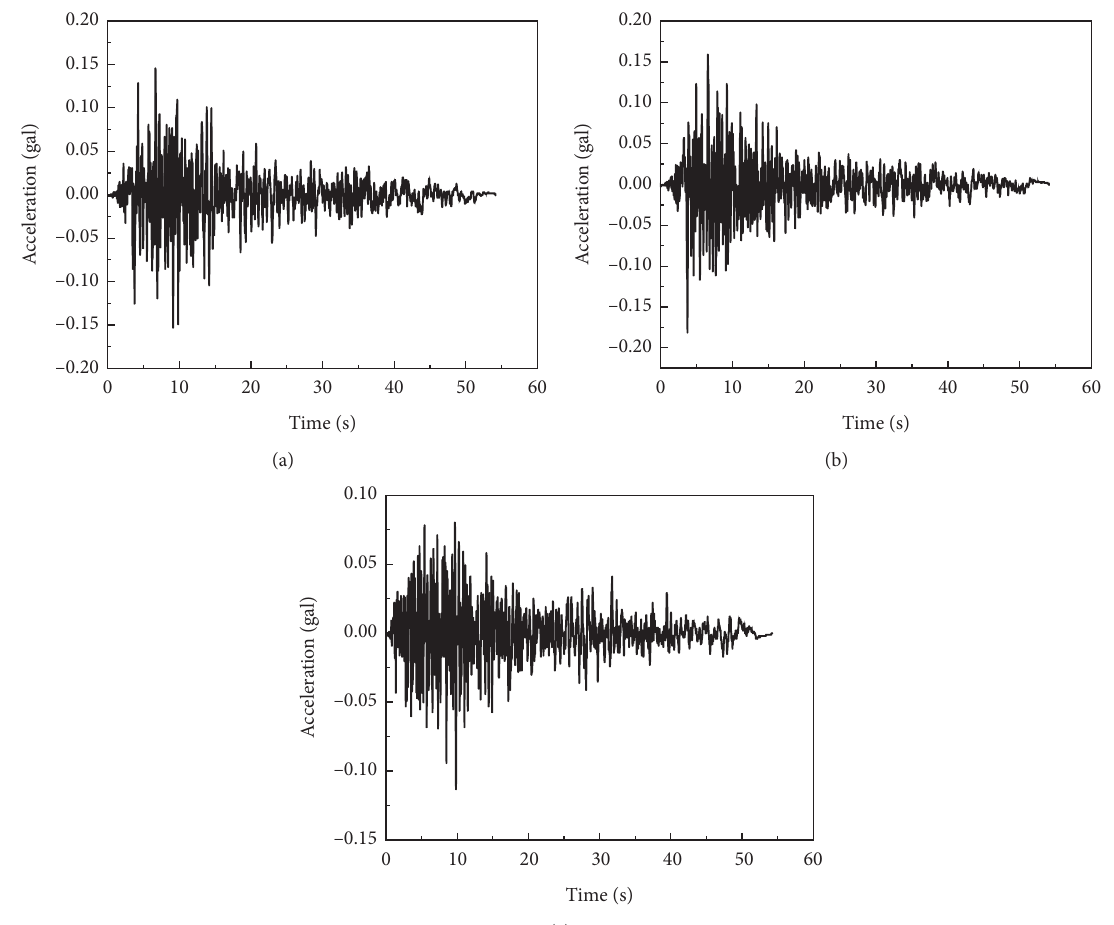
Figure 6: Taft wave source record. (a) X -direction. (b) Y -direction. (c) Z